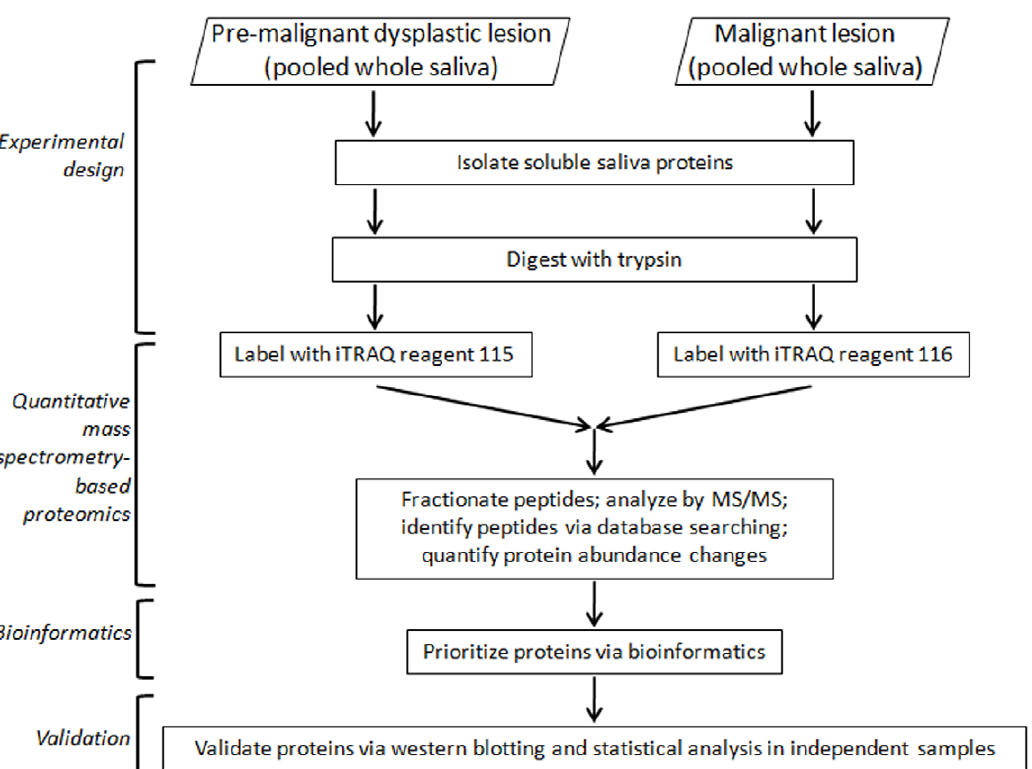
Figure 1. Biomarker discovery strategy. The parts making up our integrated strategy are shown and described in the text.